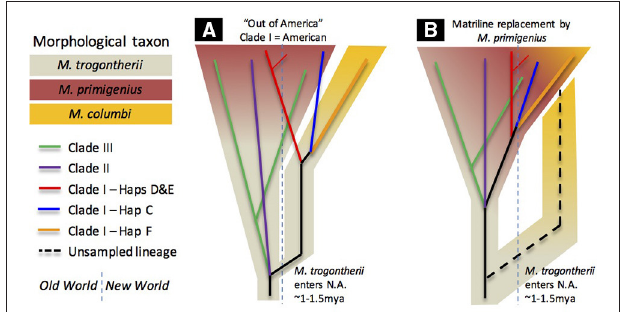
FIGURE 3 | Species/morphological tree schematics. Schematic versions of the estimated mitochondrial phylogeny are overlain on hypothetical species/morphological trees. One version (A) is consistent with the chronology estimated with a root+tip calibration scheme and a paleontological model where observed M. columbi lineages descend independently from North American M. trogontherii . The other (B) is more consistent with a tips-only calibration scheme; it assumes that the common ancestors of lineages reconstructed to date are taxonomically M. primigenius , and that some of them replaced an unobserved but once extant matriline of Columbian mammoths (dashed line). Both models assume nuclear gene interchange between divergent lineages that resulted in morphological similarity; convergence is not